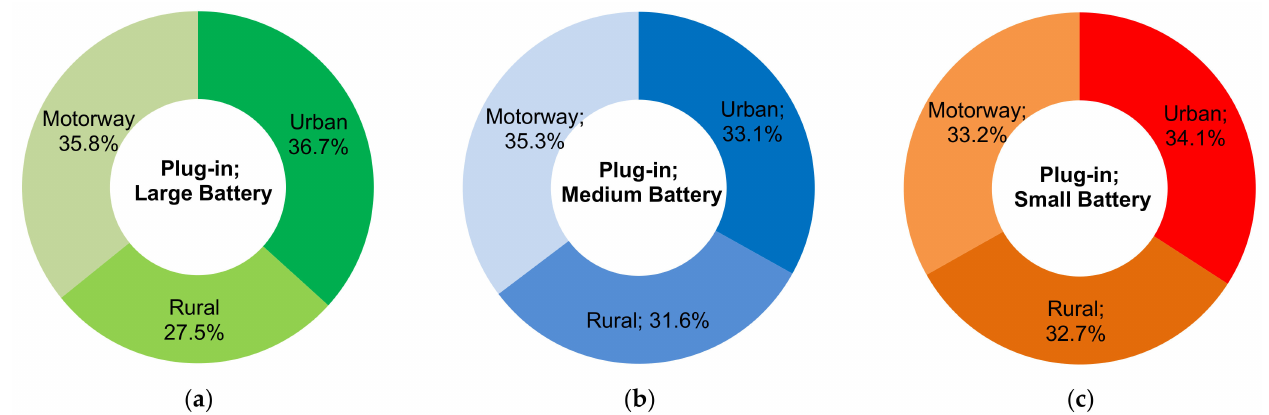
Figure 3. Comparison of the share of individual phases of the RDE test for the plug-in hybrids with a large ( a ), medium ( b ), and small ( c ) battery capacity.